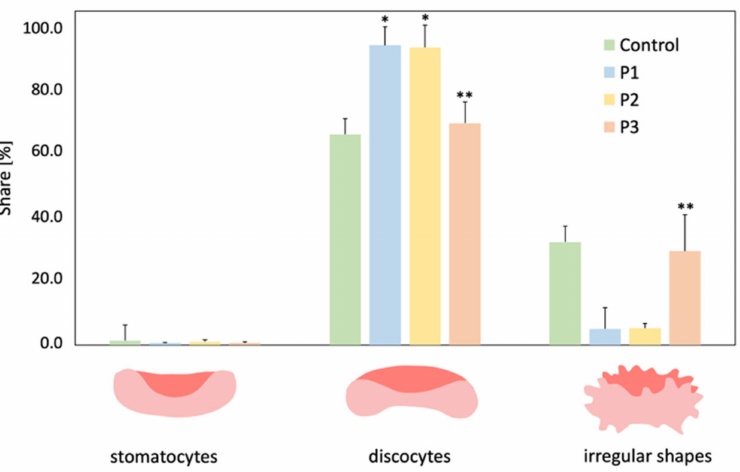
Figure 5. Percentage share of shape of RBCs modified by interaction with formulations P1, P2, and P3 in concentration 50 µ M and control. * Statistically significant differences between control and P1, P2 or P3-treated cells are denoted ( α = 0.05). ** Statistically significant differences between P3 and P1 or P2 treated cells ( α =